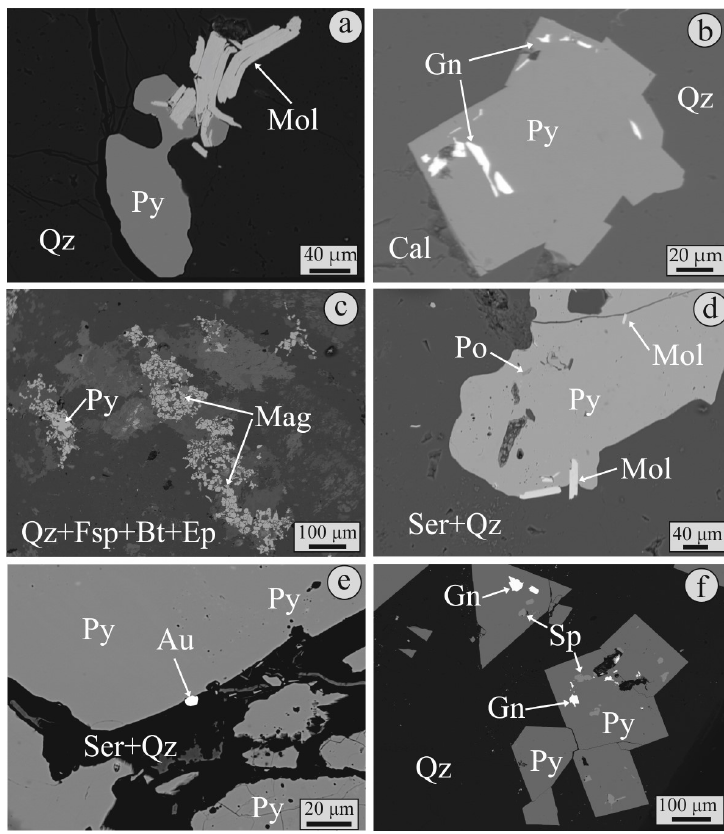
Figure 5. SEM back-scattered electron images of pyrite-bearing assemblages. ( a ) Intergrowth of pyrite (Py) and molybdenite (Mol) in quartz (Qz), D-type vein, Konos Hill prospect (sample KMSP64); ( b ) Euhedral pyrite (Py) that includes galena (Gn) in quartz (Qz) and calcite (Cal), epithermal style vein, Konos Hill prospect (sample KMSP48); ( c ) Magnetite (Mag) with pyrite (Py) associated with quartz (Qz) – feldspar (Fsp, orthoclase and/or albite) – biotite (Bt) – epidote (Ep) altered granodiorite porphyry, M-type vein, Pagoni Rachi prospect (sample KMPR74); ( d ) Pyrite (Py) including minor pyrrhotite and associated with molybdenite (Mol), in sericite (Ser) and quartz (Qz) altered granodiorite porphyry, D-type vein, Pagoni Rachi prospect (sample KMPR66); ( e ) Native gold (Au) in association with pyrite (Py) in a sericite (Ser) and quartz (Qz) matrix, D-type vein, Pagoni Rachi prospect (sample KMPR66); ( f ) Euhedral pyrite (Py) crystals in quartz (Qz) and including galena (Gn) and sphalerite (Sp), E-type vein, Pagoni Rachi prospect (sample KMPR53).